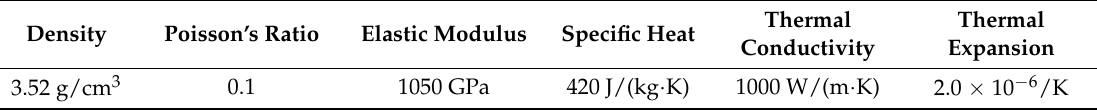
Table 2. Material physical properties of PCD tool.